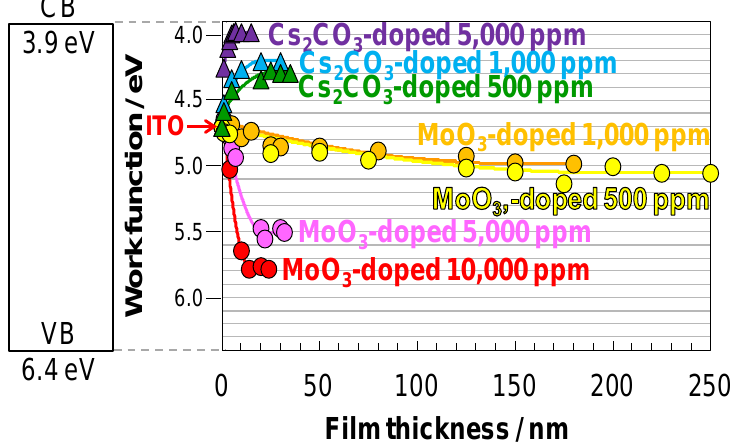
Figure 18. Work function shifts in C substrates (triangular and circular dots). Band-bending was fitted by a quadratic relationship based on the Poisson equation (solid curves).